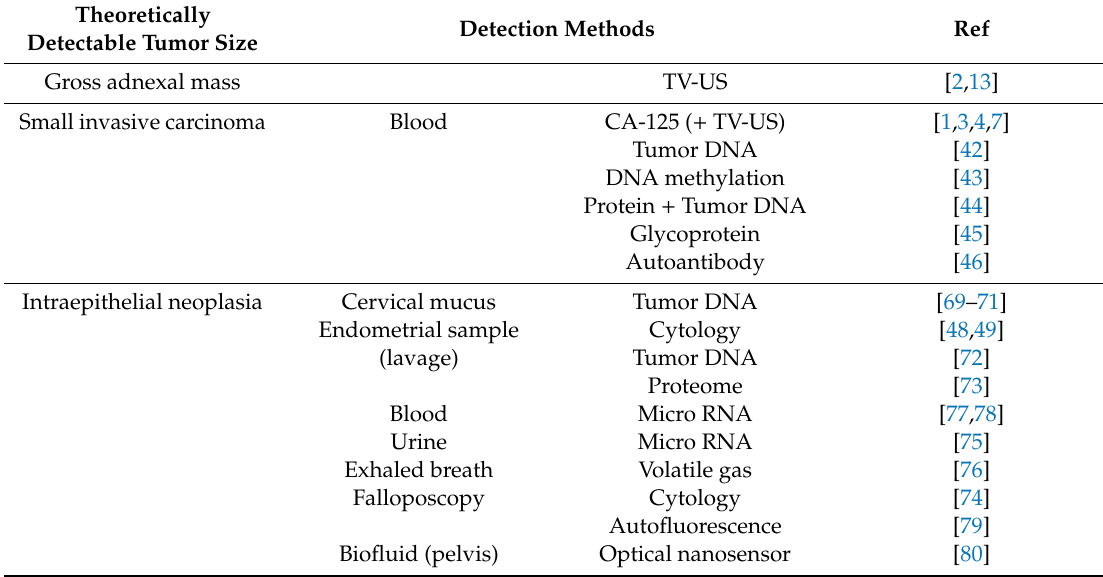
Table 1. Detection methods for high-grade serous carcinoma of the ovary and fallopian tube.